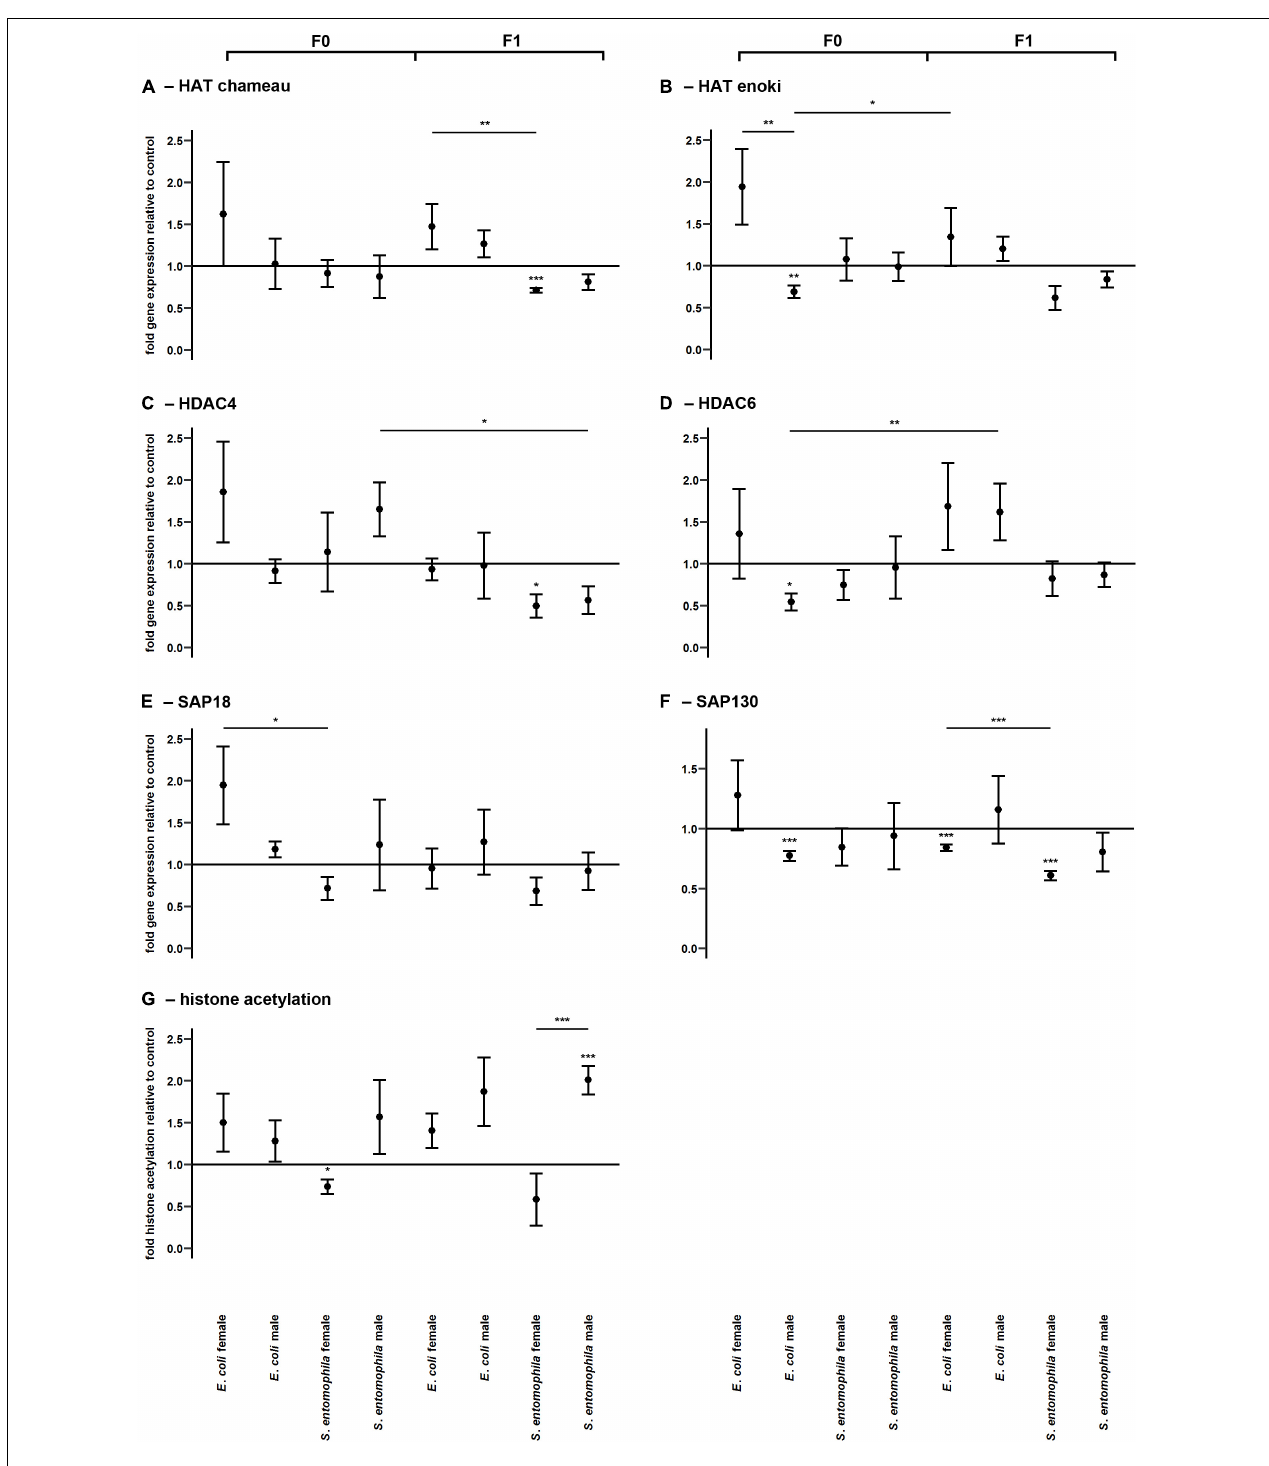
FIGURE 5 | Differential expression of genes encoding histone modifying enzymes and corresponding levels of histone acetylation. Relative expression levels of genes associated with histone modification in the parental generation reared on bacterial diets (pathogenic and non-pathogenic) or uncontaminated control diets (F0) and unchallenged offspring (F1). The target genes were: (A) HAT chameau, (B) HAT enoki, (C) HDAC4, (D) HDAC6, (E) SAP18, and (F) SAP130. (G) Corresponding levels of relative histone H3 acetylation. Relative fold changes for each gene were set to 1 for the control treatment and normalized against the RPL3 housekeeping gene. Results represent the mean values of three independent biological replicates for relative gene expression and four replicates for relative histone acetylation. Error bars indicate the standard error of the mean. Significance levels: ∗ p < 0.05, ∗∗ p < 0.01, ∗∗∗ p < 0.001.